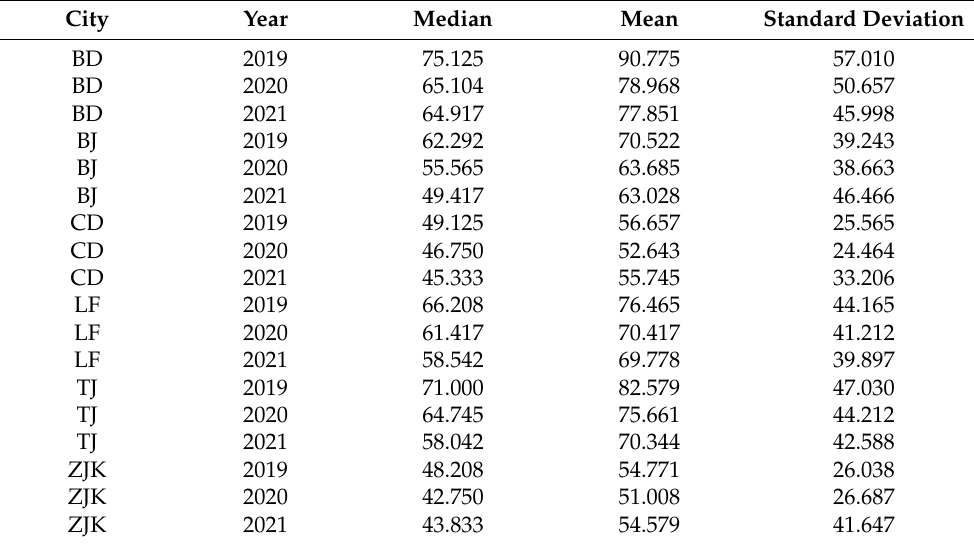
Table A1. Statistical results of AQI of Beijing and its neighboring